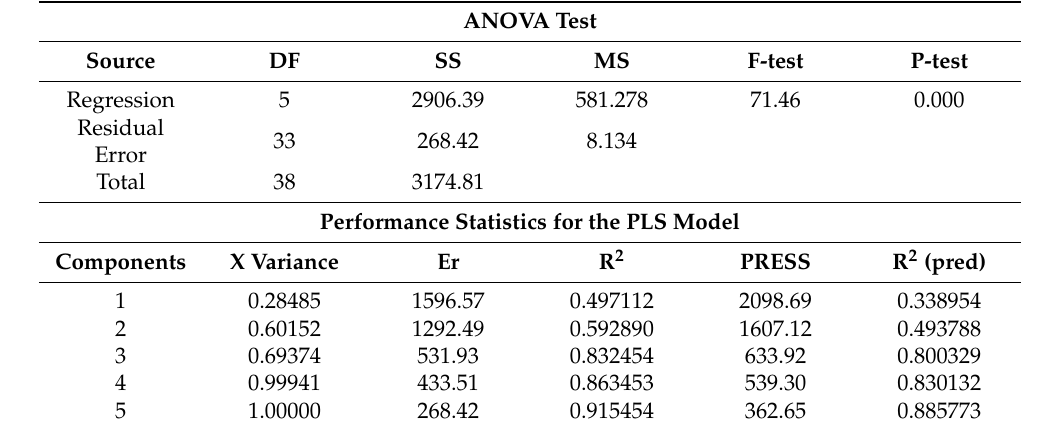
Figure 9. PLS response plot (5 components)—E u 50 . Table 7. Summary of the performance statistics for the PLS model—E u 50